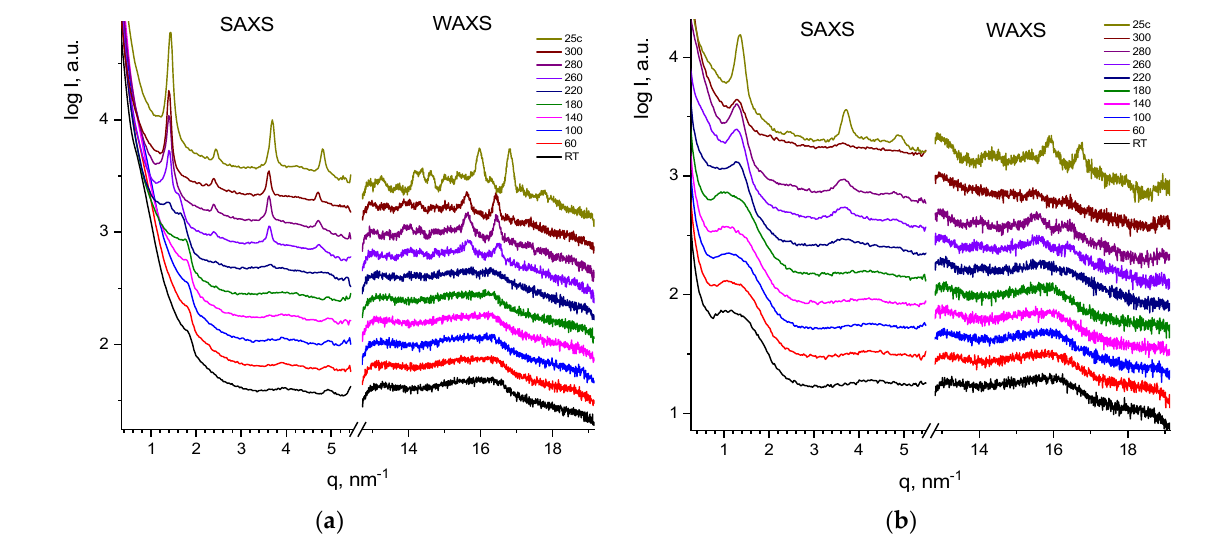
Figure 3. SWAXS curves for as-received G1 ( a ) and G2 ( b ) at varied temperatures during first and second heating runs (up 300 °C) with subsequent cooling. The curves are shifted vertically for clarity.